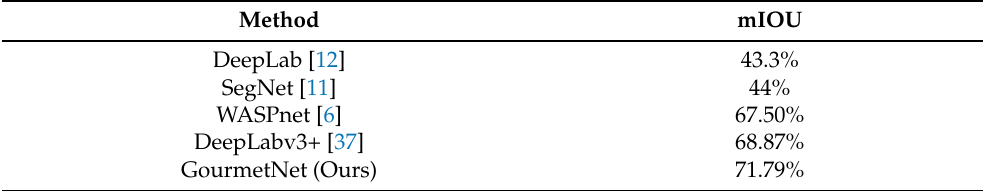
Table 3. GourmetNet results and comparison with SOTA methods for the UNIMIB2016